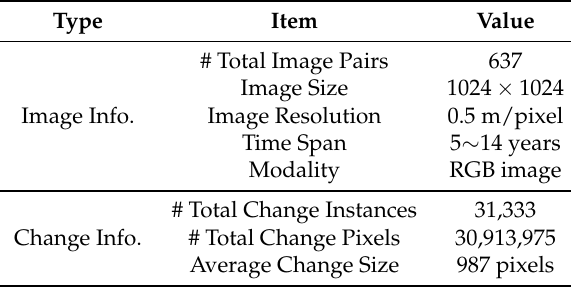
Table 2. A summary of LEVIR-CD